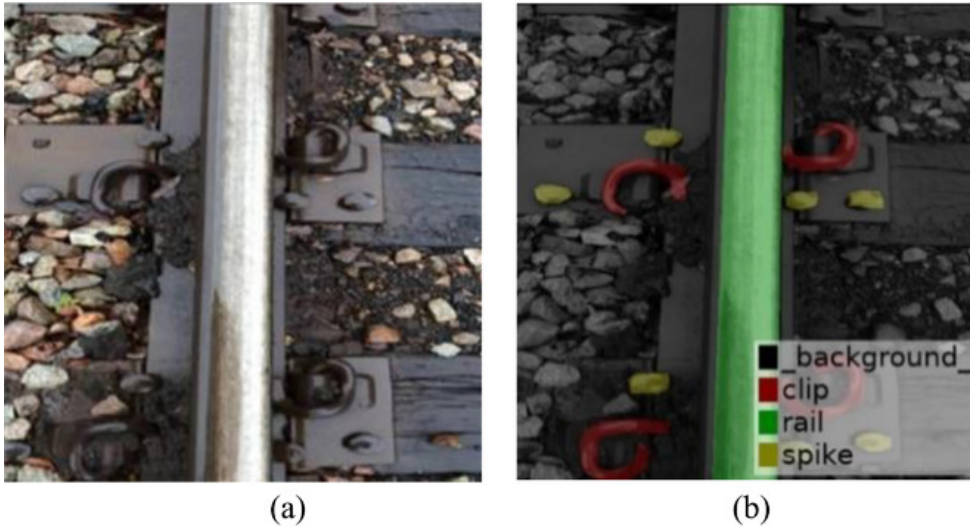
Figure 5. Example of original image and label result: ( a ) ground truth; ( b ) instance label visualization. Reproduced with Permission from Blackwell